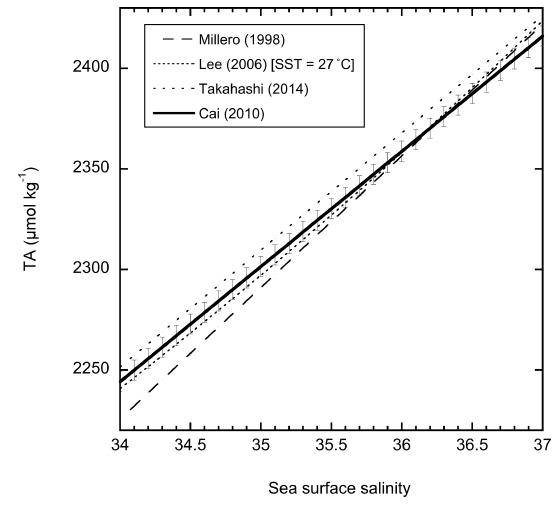
Figure 5. Relationships of surface water TA with salinity. The re- lationship of Cai et al. (2010), with standard error shown as error bars, is used to calculate pH and (cid:127) Ar from f CO 2w